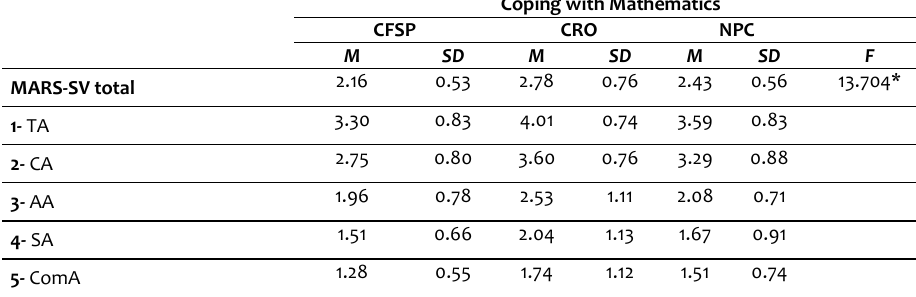
Table 3. Comparison of Overall MARS-SV and its Sub-Scale Scores regarding Dominantly Preferred Strategy of Coping with Mathematics Coping with Mathematics CFSP CRO